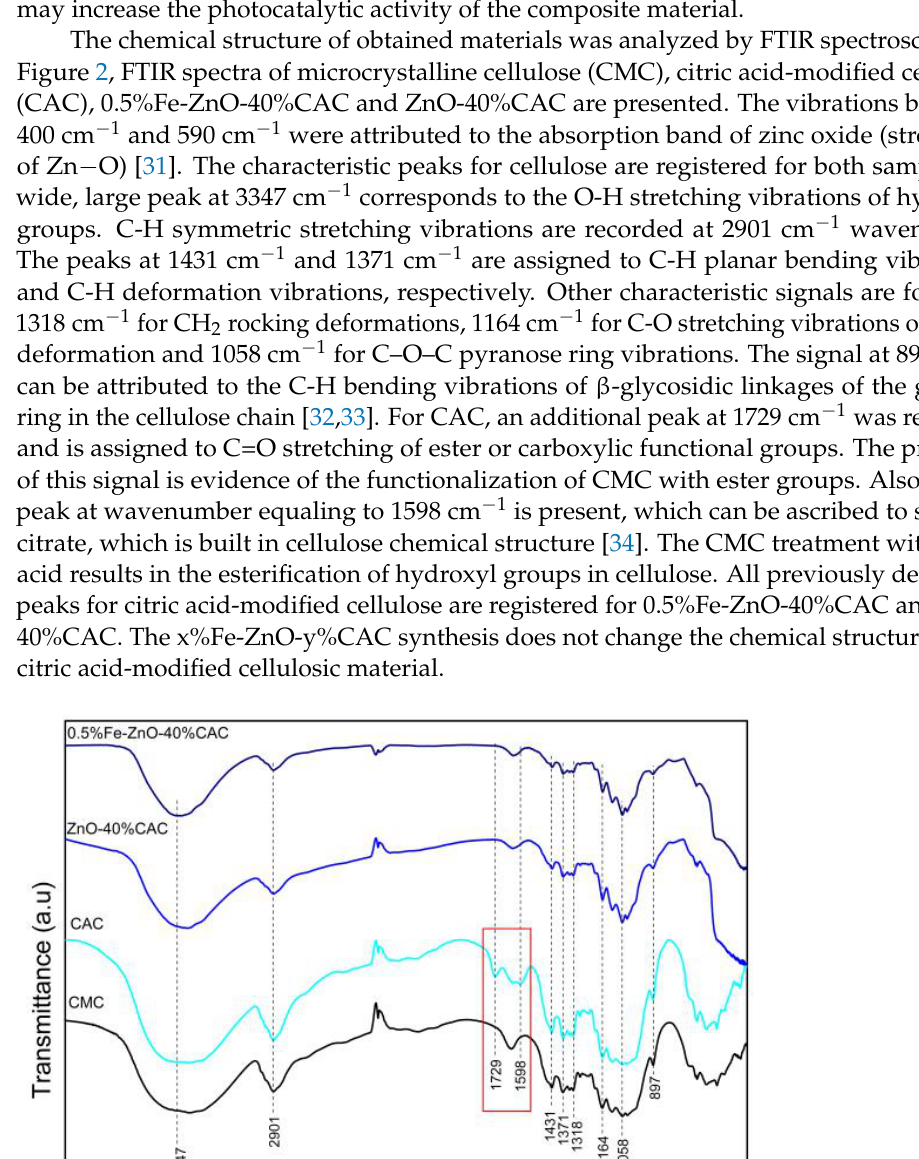
4 of 19 Table 1. Average crystallite size, lattice parameters (a = b (Å ), c (Å ), c/a ratio) and energy bandgap for hybrids from the series x%Fe-ZnO-y%CAC. Sample Name